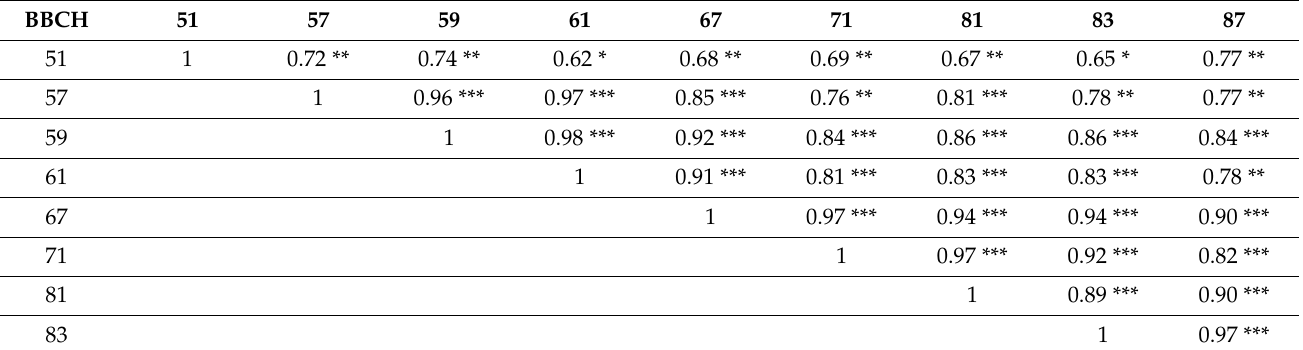
Table 3. Matrix of correlations between BBCH generative phenophases in blueberries cultivated in the low hilly area of